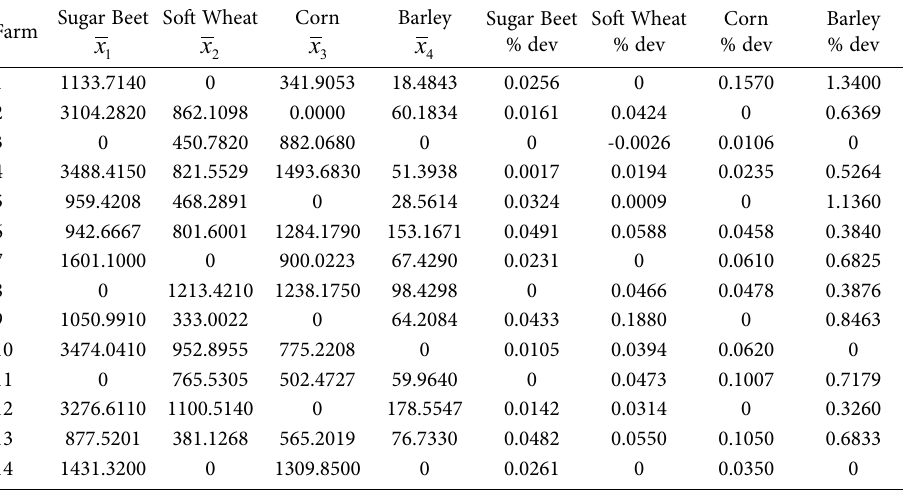
Table 8. Estimated Output Levels, x and Percent Deviation (dev) for the sample with missing crop production (compare with Table